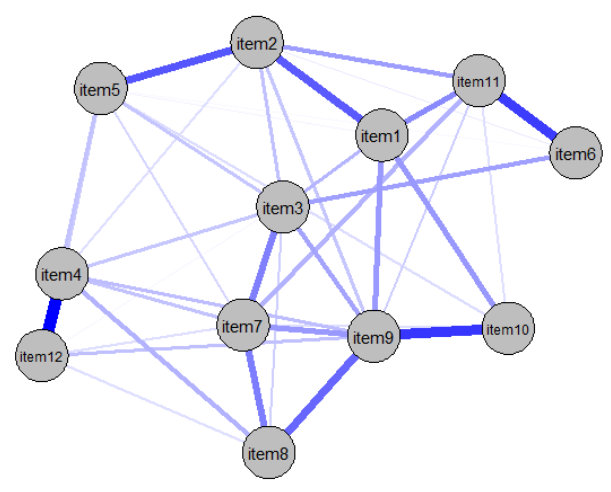
Figure 1. Partial correlation network of FoP-SF items.